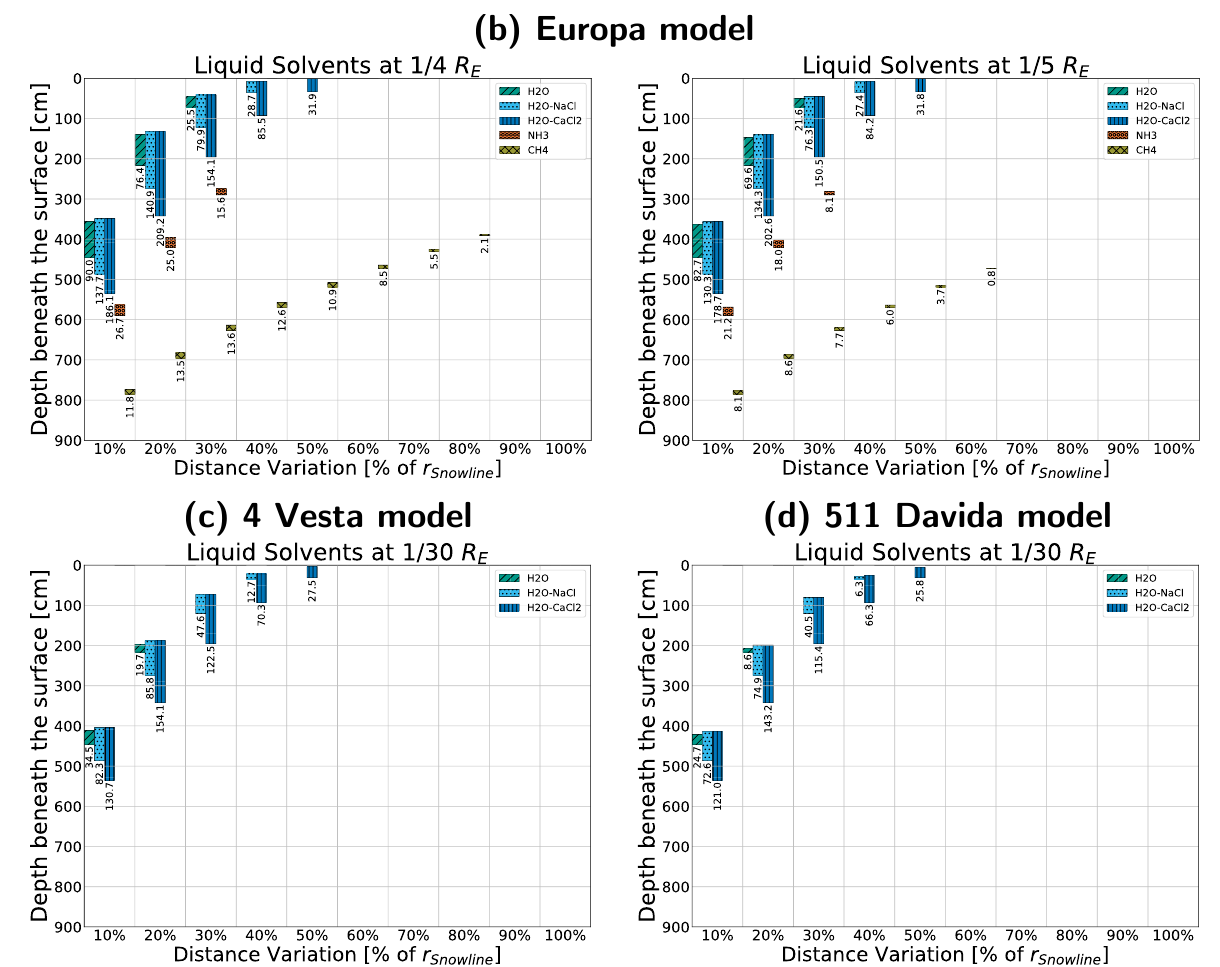
Figure A9. Comparisons between different approximations of smaller bodies with sizes and densities close to their real-life counterparts and crust densities ρ surface , as seen in Table 2: ( a ) Jupiter’s moon R earth , using an icy crust; ( b ) Jupiter’s moon Ganymede ( ρ body = 1.936 g )shown for sizes 1 , 1 2 3 cm 3 R earth , using an icy crust; ( c ) Asteroid 4 Vesta Europa ( ρ body = 3.014 g ) shown for sizes of 1 , 1 5 4 cm 3 R earth , using a rocky, freshwater crust; ( d ) Asteroid 511 ( ρ body = 3.58 g ) shown for a size of 1 30 cm 3 R earth , using a rocky, freshwater crust with modified Davida ( ρ body = 2.48 g ) shown for a size of 1 30 cm 3 density ρ surface = ρ body